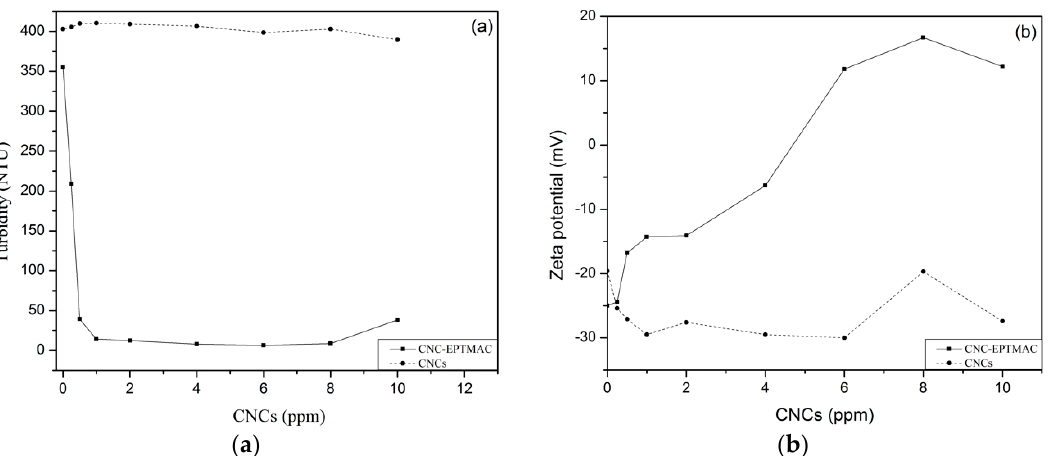
Figure 7. Flocculation test of modified versus unmodified CNC ( a ) turbidity and ( b ) Zeta potential change.